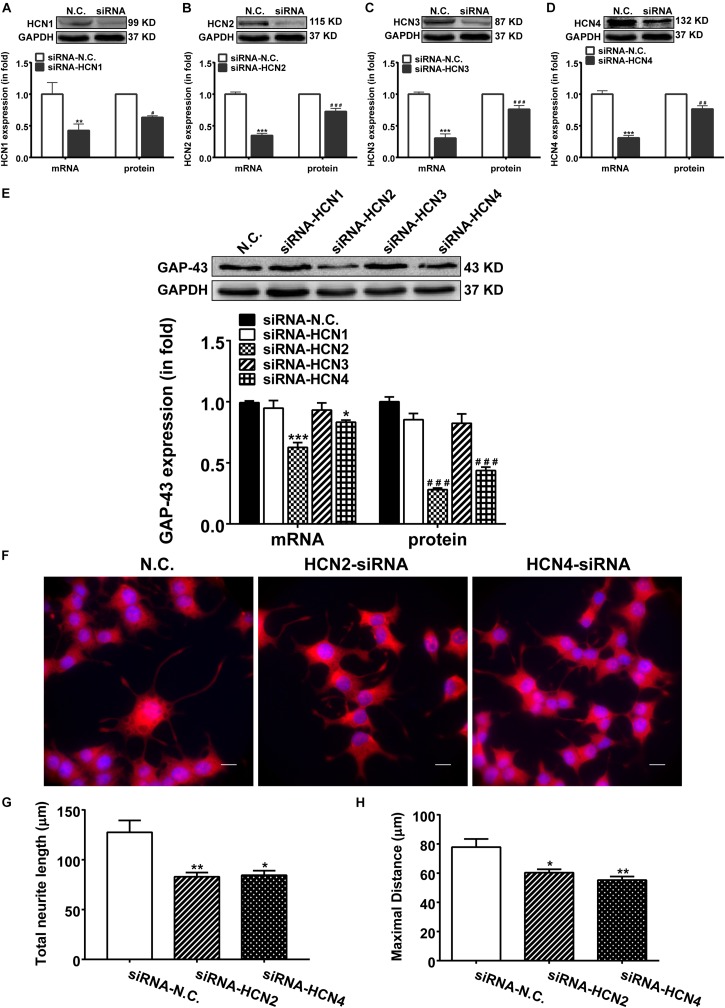
Knocking-down HCN2 and HCN4 expression with siRNAs inhibited GAP-43 expression and neurite outgrowth in PC12 cells. NGF-treated PC12 cells were transiently transfected with the negative control siRNA (NC-siRNA) or with the siRNA respectively for HCN1, HCN2, HCN3 or HCN4 using Lipofectamine® RNAiMAX Reagent for 48 h before cells were harvested for detection. (A–D) The mRNA and protein expressions of HCN1-4 isoforms assayed by qPCR and western blotting in comparison to GADPH in NGF-treated PC12 cells. ∗∗p < 0.01, ∗∗∗p < 0.001 vs. negative control siRNA (N.C.) in the mRNA level. #p < 0.05, ##p < 0.01, ###p < 0.001 vs. N.C. in the protein level. (E) Representative western blotting results (upper) and the densitometric analysis of GAP-43 mRNA and protein expressions (lower) (n = 3–6 independent experiments). ∗p < 0.05, ∗∗∗p < 0.001 vs. N.C. in the mRNA level. ###p < 0.001 vs. N.C. in the protein level. (F) Immunofluorescent stains of GAP-43 in PC12 cells transiently transfected with siRNA targeting HCN2 or HCN4. Scale bar, 10 μm. (G,H) Quantification of neurite morphological parameters (total length of neurite outgrowth and longest process per cell). Results are calculated from three independent experiments and presented as mean ± SEM, 50 < n < 84, ∗p < 0.05, ∗∗p < 0.01 vs. N.C.